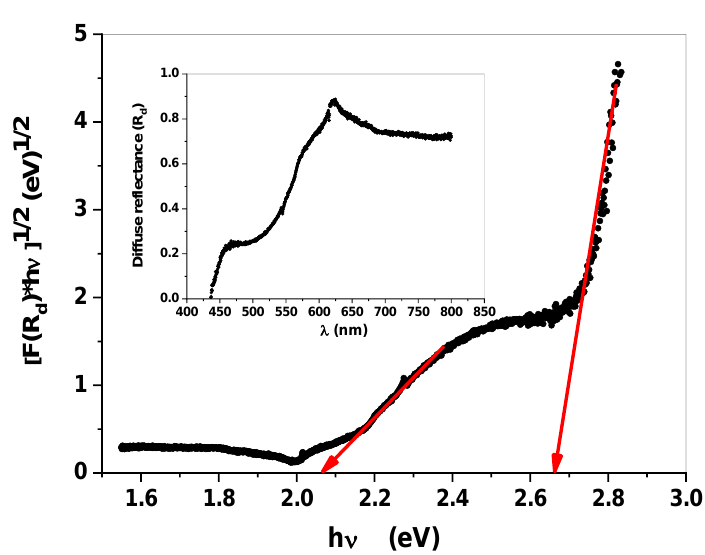
Figure 11. The relation between [F(Rd )h ν ] 1/2 versus (h ν ) of powder-form compound 4 . The inset figure shows DRS spectra.